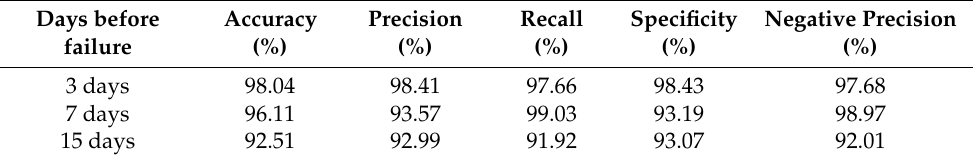
Table 7. Converter fault detection performance indices by